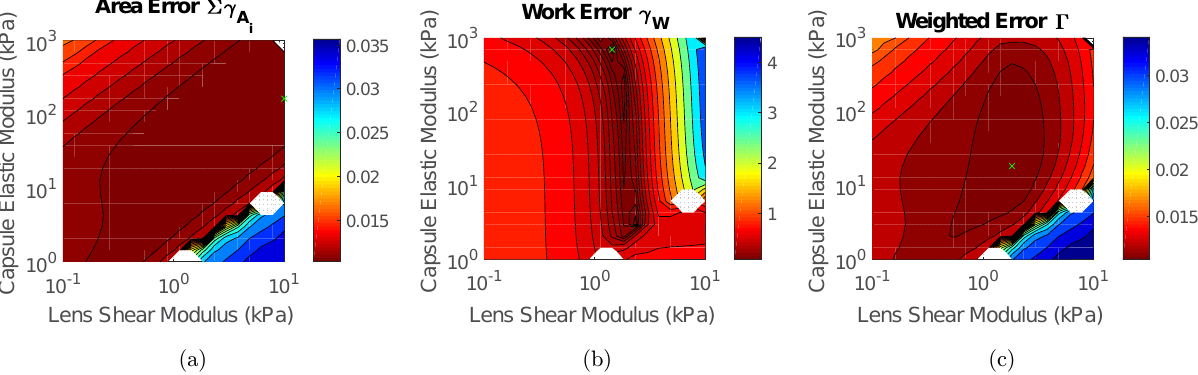
Fig. 5. Contour plots showing the relative error in ¯tting (a) cross-sectional area ( (cid:2) (cid:4) A ; i Þ , (b) work (cid:4) W , and (c) the weighted error metric (cid:1) combining the two for the decapsulated porcine lens as a function of lens shear modulus G lens ( x -axis) and capsule elastic modulus E capsule ( y -axis). The work error is minimized for in¯nitely many combinations of G lens and E capsule , indicating that simply ¯tting the force – displacement curve will not yield unique values for mechanical